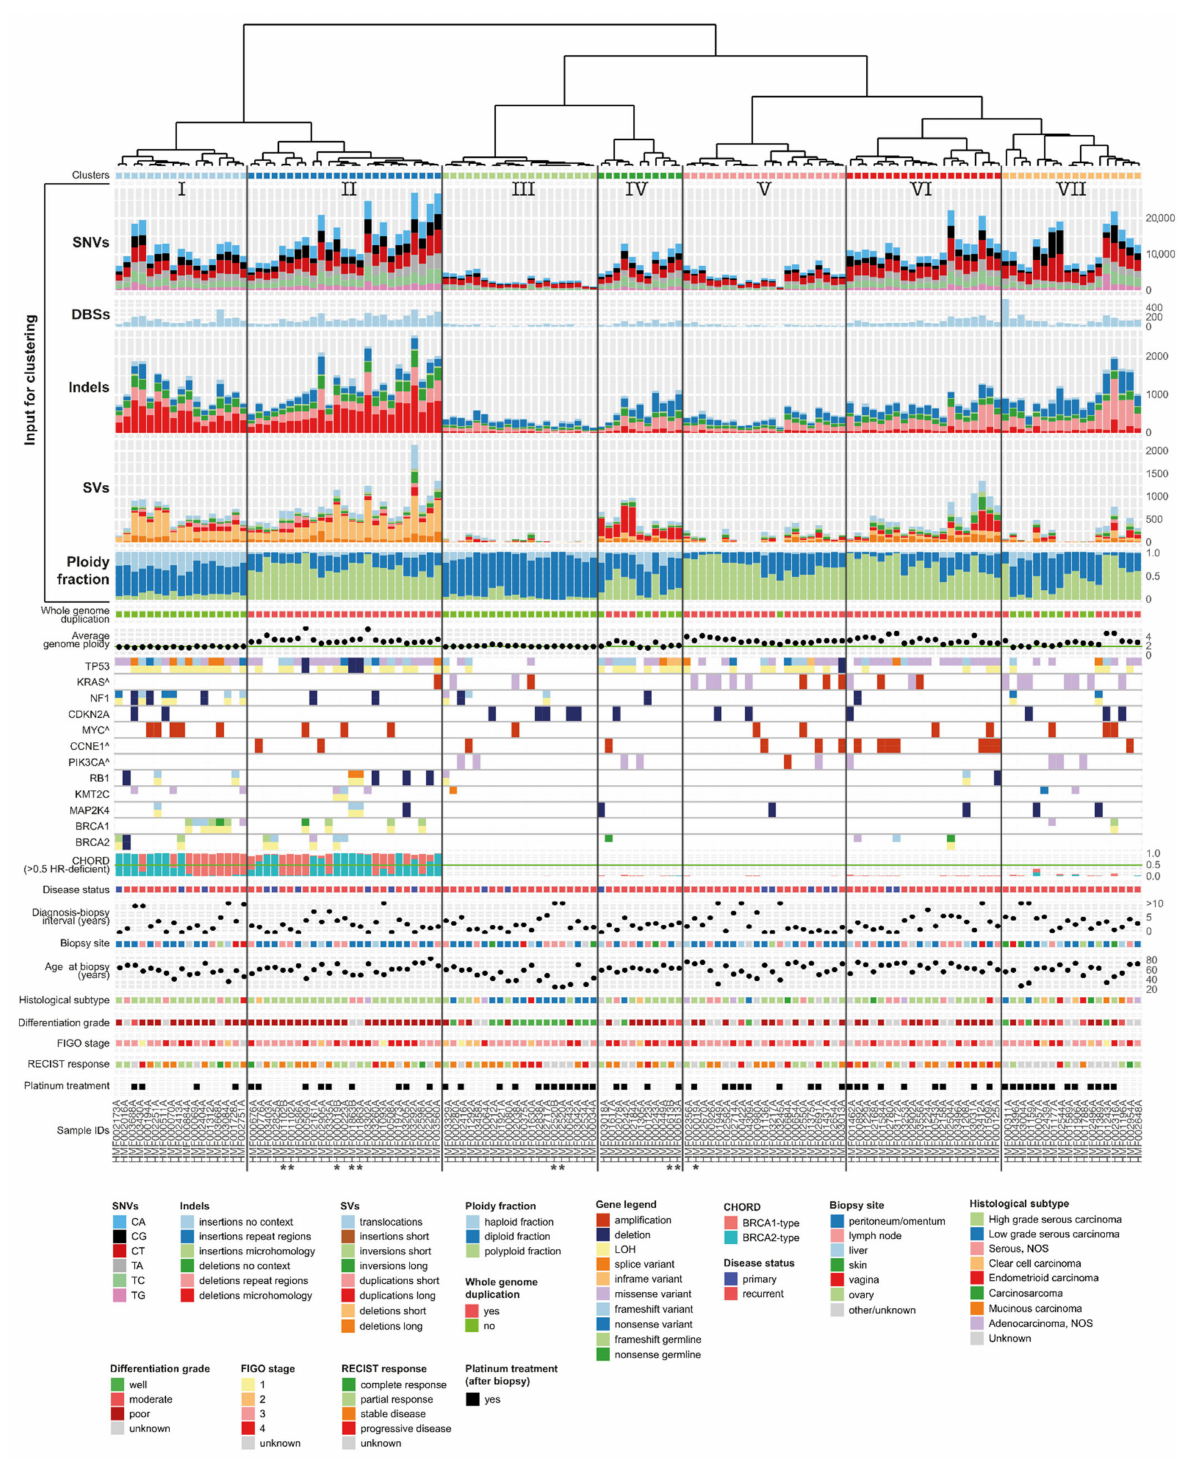
Figure 4. Unsupervised hierarchical clustering based on genomic features reveals distinct subgroups. Dendrogram and cluster plot with seven clusters. Input for clustering consisted of single nucleotide variants (SNVs), dinucleotide variants (DBSs), insertions and deletions (indels), structural variants (SVs), and ploidy fraction (top rows). The plot has been annotated with genetic and clinical data to interpret specific features of each cluster. For oncogenes (indicated by ˆ) a single row is shown which indicates amplification or a mutation, while tumor suppressor genes are represented by two rows to visualize the effect on both alleles. For five patients, two time points were included (indicated by *), four pairs clustered